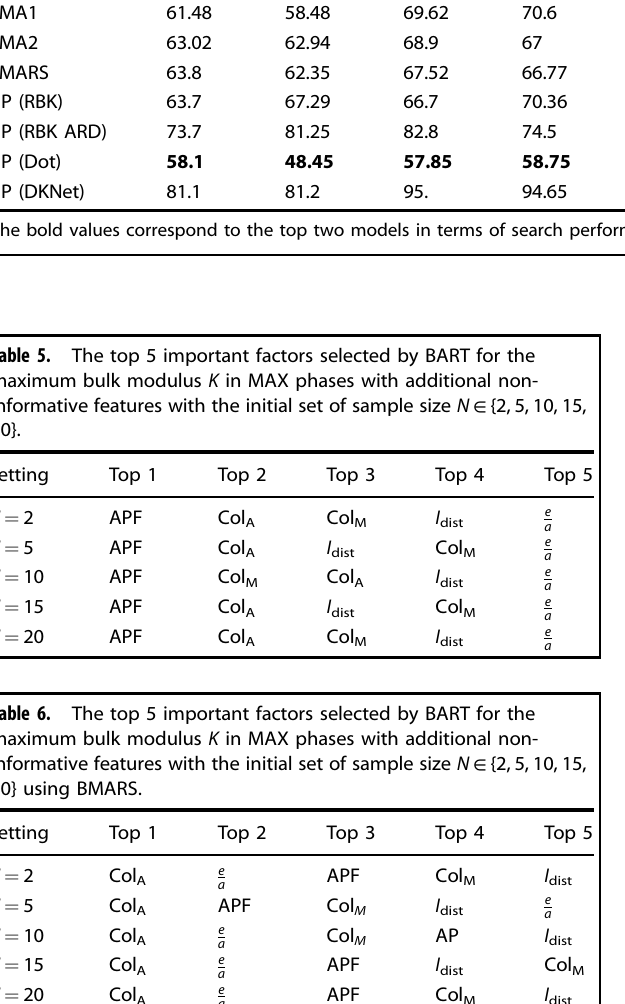
Table 4. The mean value and interquartile range of the number of experiments based on each model to fi nd the maximum bulk modulus K in MAX phases with additional non-informative features with the initial set of sample size N ∈ {2, 5, 10, 15, 20}. Model